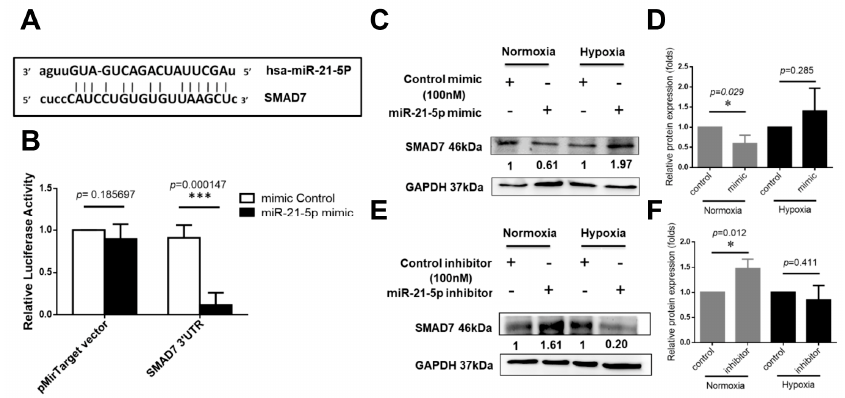
Figure 4. SMAD7 is a direct target of hsa-miR-21-5p. ( A ) The 3 ′ -UTR sequences of SAMD7 is cloned at the 3 ′ end of luciferase reporter gene in the pMirTarget plasmid. The predicted binding site of hsa-miR-21-5p on the region of 3 ′ -UTR sequence of SMAD7 (SMAD7 3 ′ -UTR) was shown. The “seed sequences” were indicated by lowercase; ( B ) Luciferase reporter assay. HEK293 cells were transfected with mimic-miR-21-5p or mimic control while transfection of pMirTarget plasmid or SMAD7 3 ′ -UTR plasmid. *** p < 0.001, significant difference between two groups; ( C ) The effect of mimic-miR-21-5p on SMAD7 protein expression and ( D ) quantification of relative SMAD7 expression; ( E ) the effect of inhibitor miR-21-5p on SMAD7 protein expression and ( F ) quantification of relative SMAD7 expression. * p < 0.05, *** p < 0.001, significant difference between two groups.